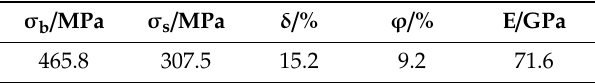
Table 1. Material properties of the 2024 ‐ T4 aluminum alloy.